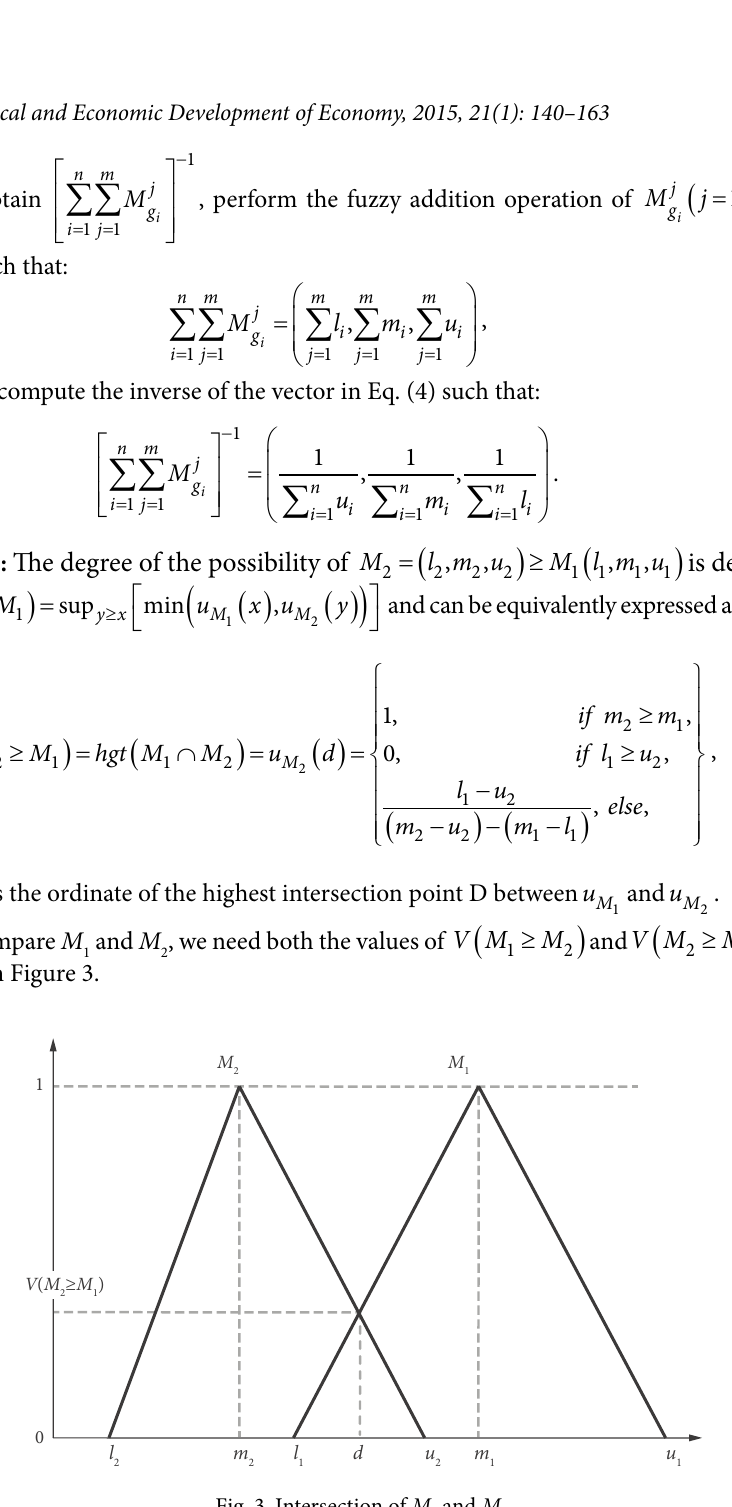
Fig. 3. Intersection of M